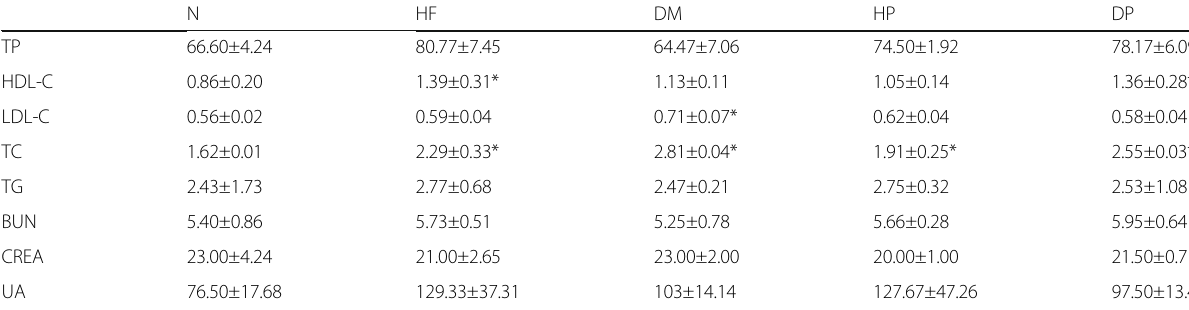
Table 1 Biochemical parameters for all rats at the end of the study N HF DM HP